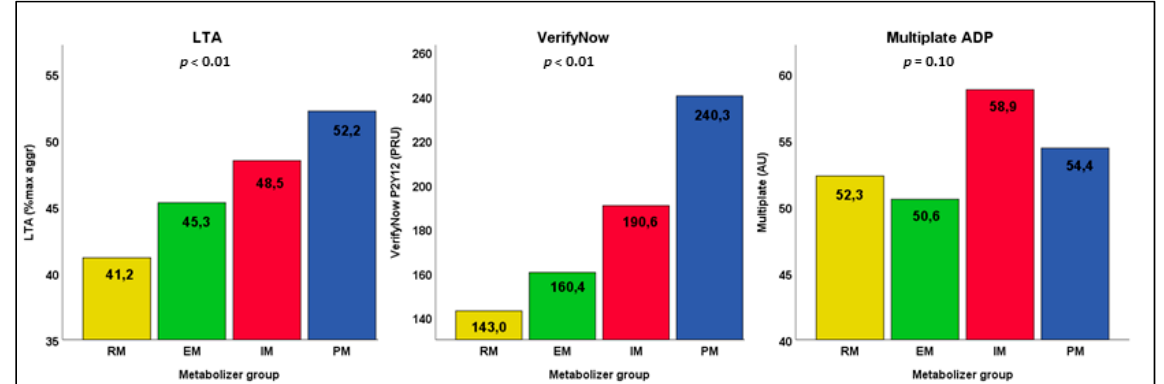
Figure 1. Mean platelet reactivity as measured by three platelet function tests in the clopidogrel group expressed per group of CYP2C19 metabolism. Differences in platelet reactivity per group of CYP2C19 metabolism were measured using ANOVA. Poor metabolizers (PM) have genotype CYP2C19 *2/*2, intermediate metabolizers (IM) CYP2C19 *1/*2, *1/*3, or *2/*17, extensive metabolizers (EM) CYP2C19 *1/*1, and rapid metabolizers (RM) CYP2C19 *1/*17 or *17/*17. Table 3. Mean platelet reactivity as measured by the three platelet function tests, expressed per group of CYP2C19 metabolism. Platelet Function Test